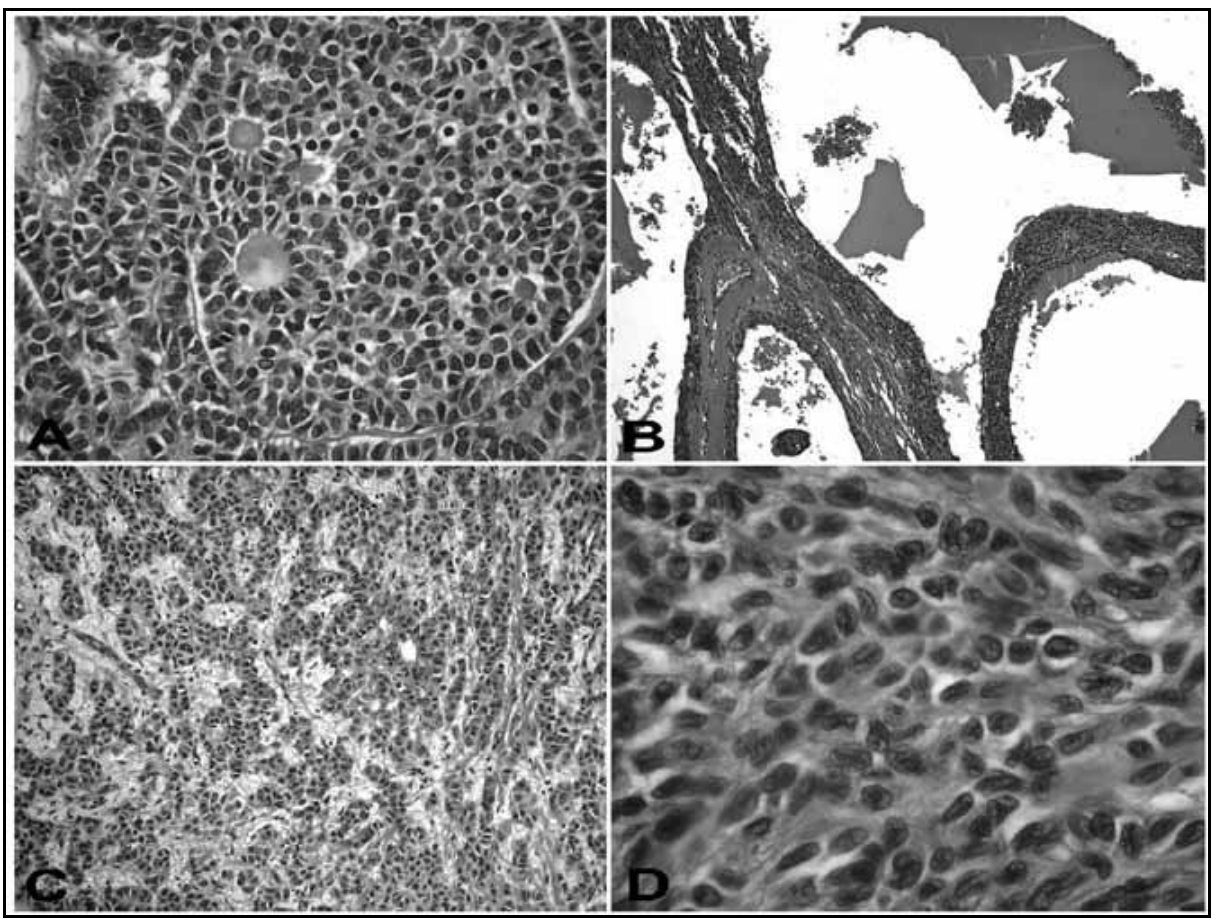
Figure – Granulosa cell tumor microscopic aspects: A: microfolicular pattern and Call-Exner bodies (HE X100); B: macrofolicular pattern (HE 40X); C: trabecular or cord-like pattern (HE 40X); D: solid, diffuse or sarcomatoid pattern (HE